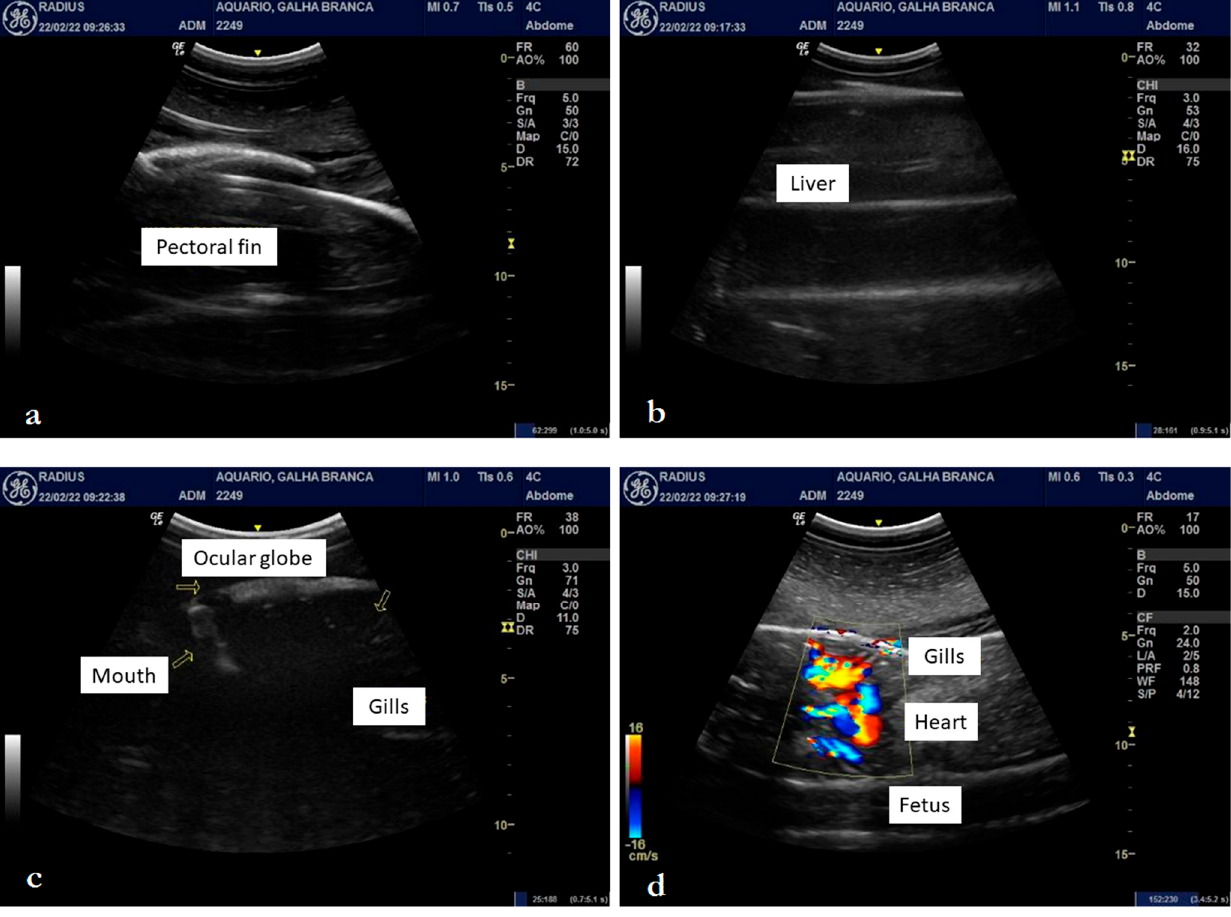
Figure 2. Ultrasonography of a female Triaenodon obesus (Rüppell, 1837) in late pregnancy: fetal orientation (brain/tail) and pectoral fins ( a ), hypoechogenic liver ( b ), eyes and gills ( c ), and heart with individualized chambers ( d